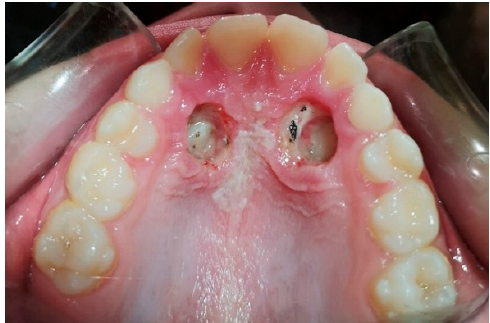
Figure 6. Intra-oral photo 1 week after surgery.